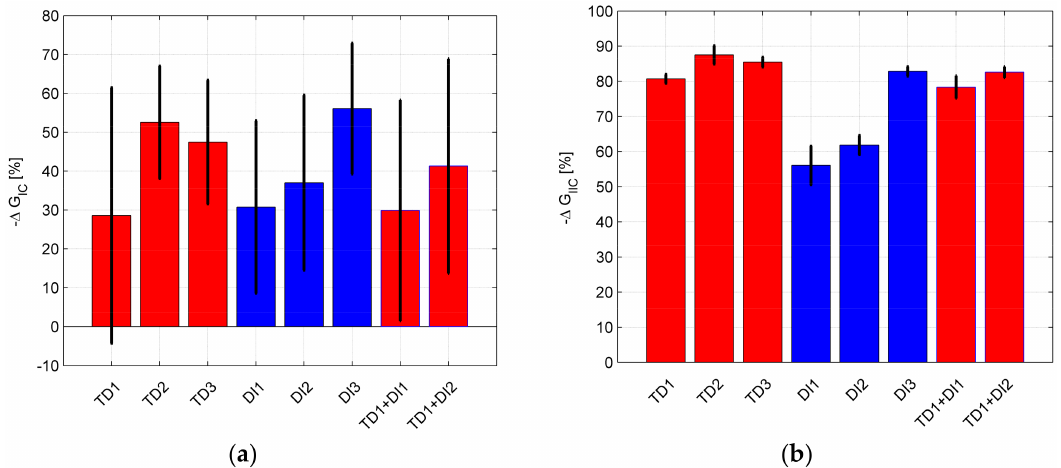
Figure 9. Relative results of the mechanical testing in relation to reference case (RE): ( a ) mode-I fracture toughness energy drop; ( b ) mode-II fracture toughness energy drop.